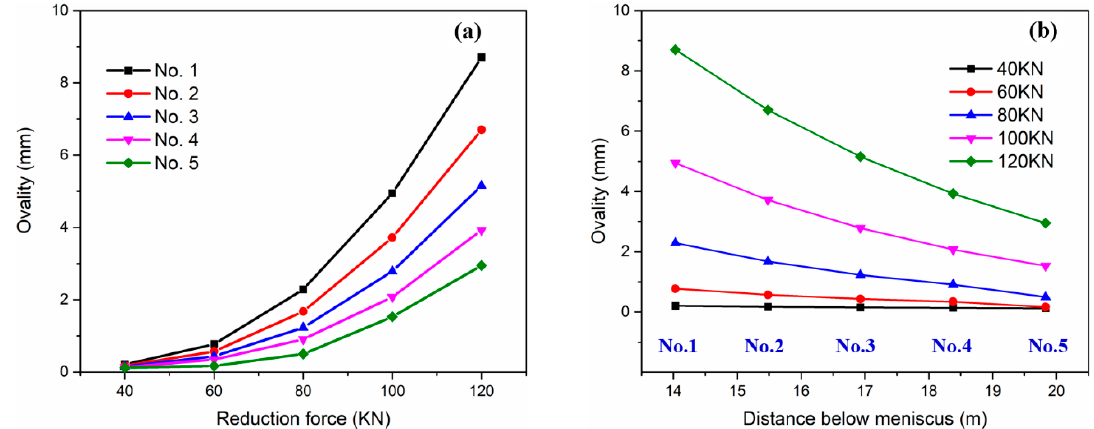
Figure 9. Ovality of round bloom after SR ( a ) different reduction forces, ( b ) different reduction positions.